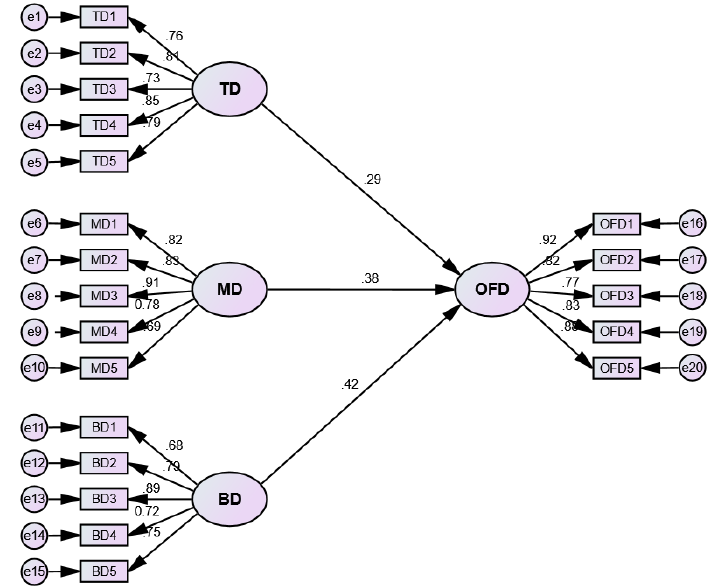
Fig. 2. Research structural